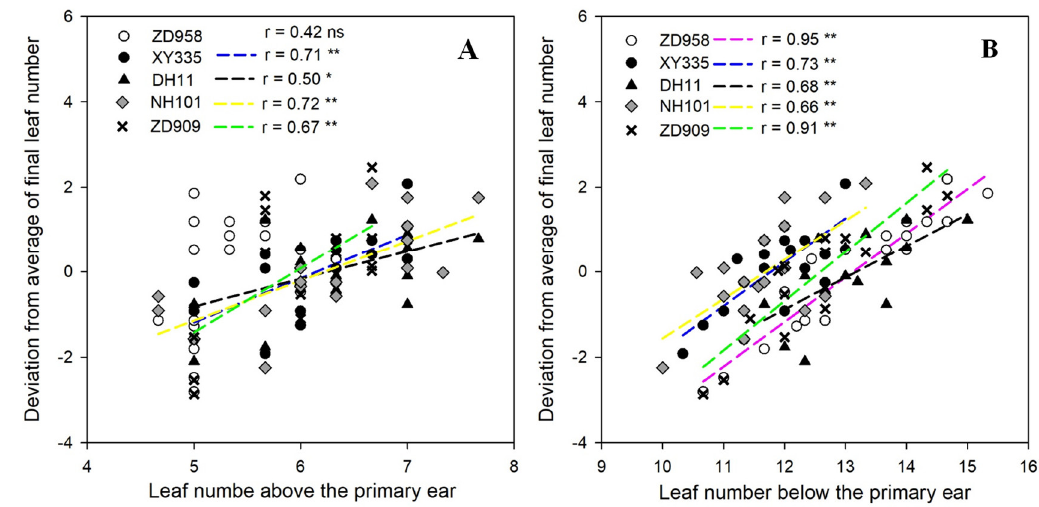
Figure 3. Relationships between deviation from the averages of final leaf numbers and leaf numbers above ( A ) and below ( B ) the primary ear for each cultivar across all locations. * and ** indicate that the correlation is significant at the p < 0.05 level and p < 0.01 level, respectively; ns means that the correlation is not significant at the p < 0.05 level.